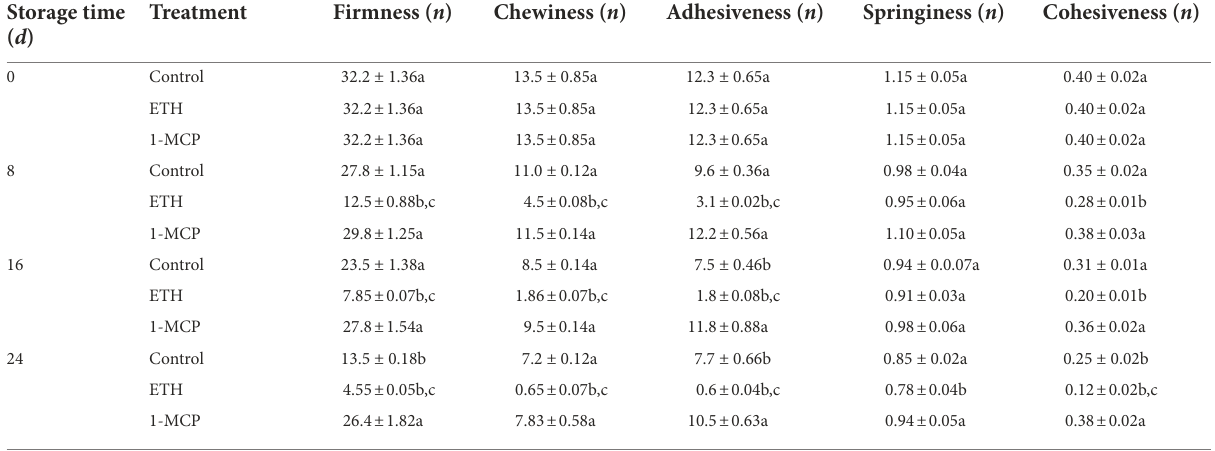
Different letters indicate statistically significant differences ( p <